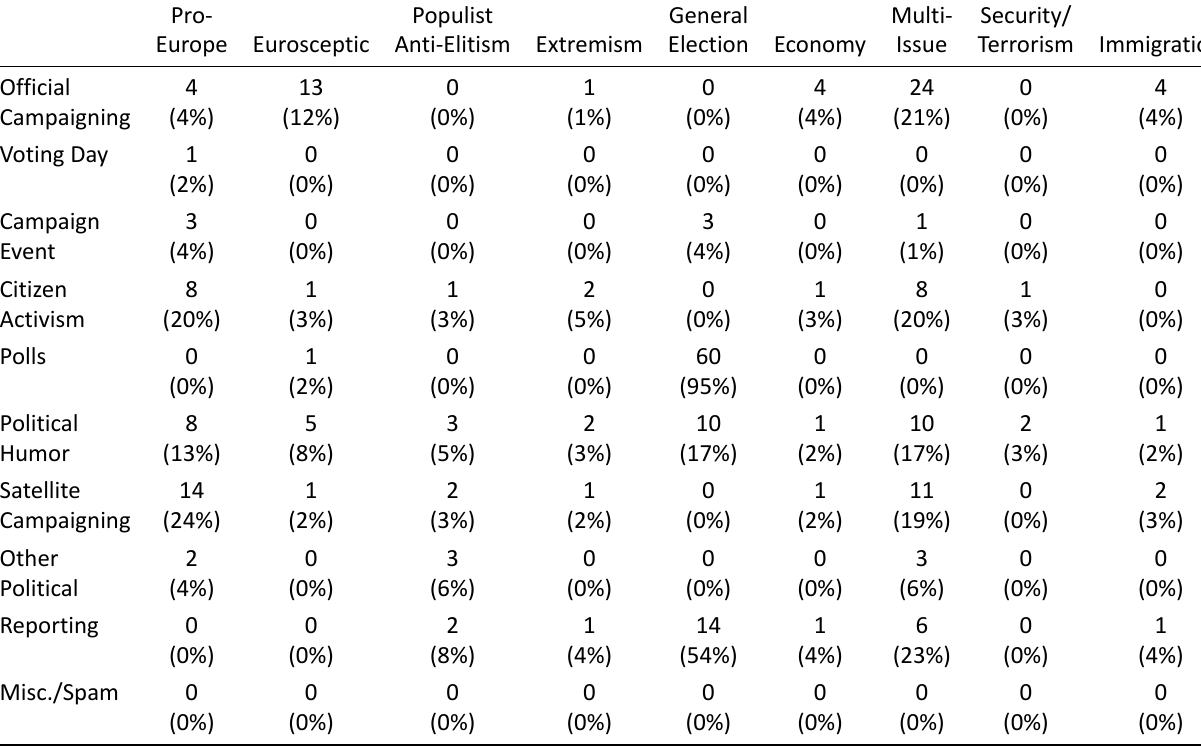
Table 5. Cross tabulations of visuals modes and themes in ‘General’ sample. Pro-